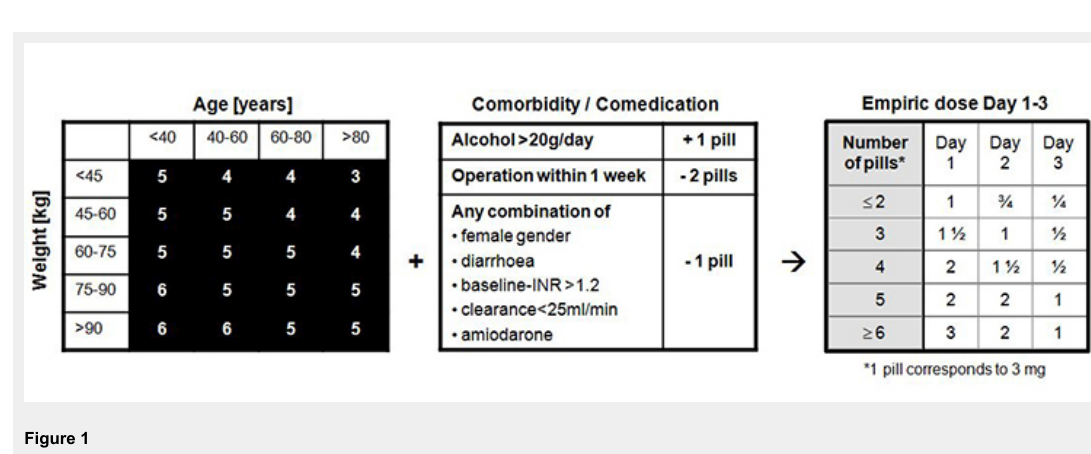
Box Plot showing the absolute error in estimating GFR (inulin clearence as the gold standard). CYSA, BTPA, CKCA, MDRDA, ALMA = absolute error in estimating the GFR using algorithms based respectively on Cystatin C; Beta-trace protein, creatinine and anthropometric